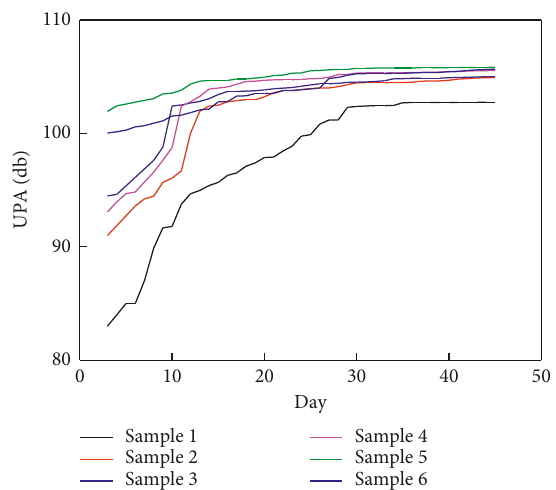
Figure 5: UPA versus curing period for FMLS.